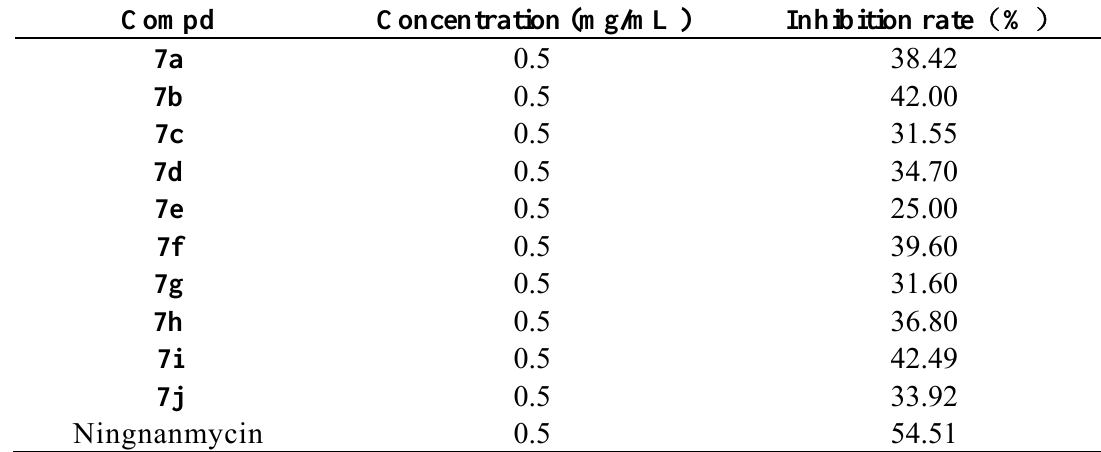
Table 3. The inhibitory activity of compounds 7a~7j to